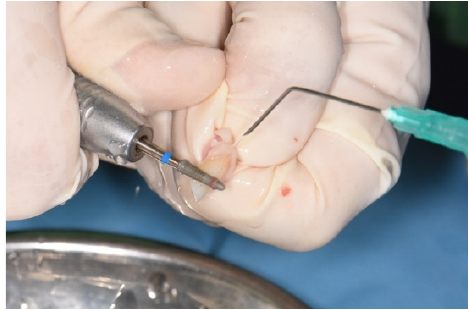
Figure 5. The enamel, cement and periodontal ligaments of the extracted teeth were removed.